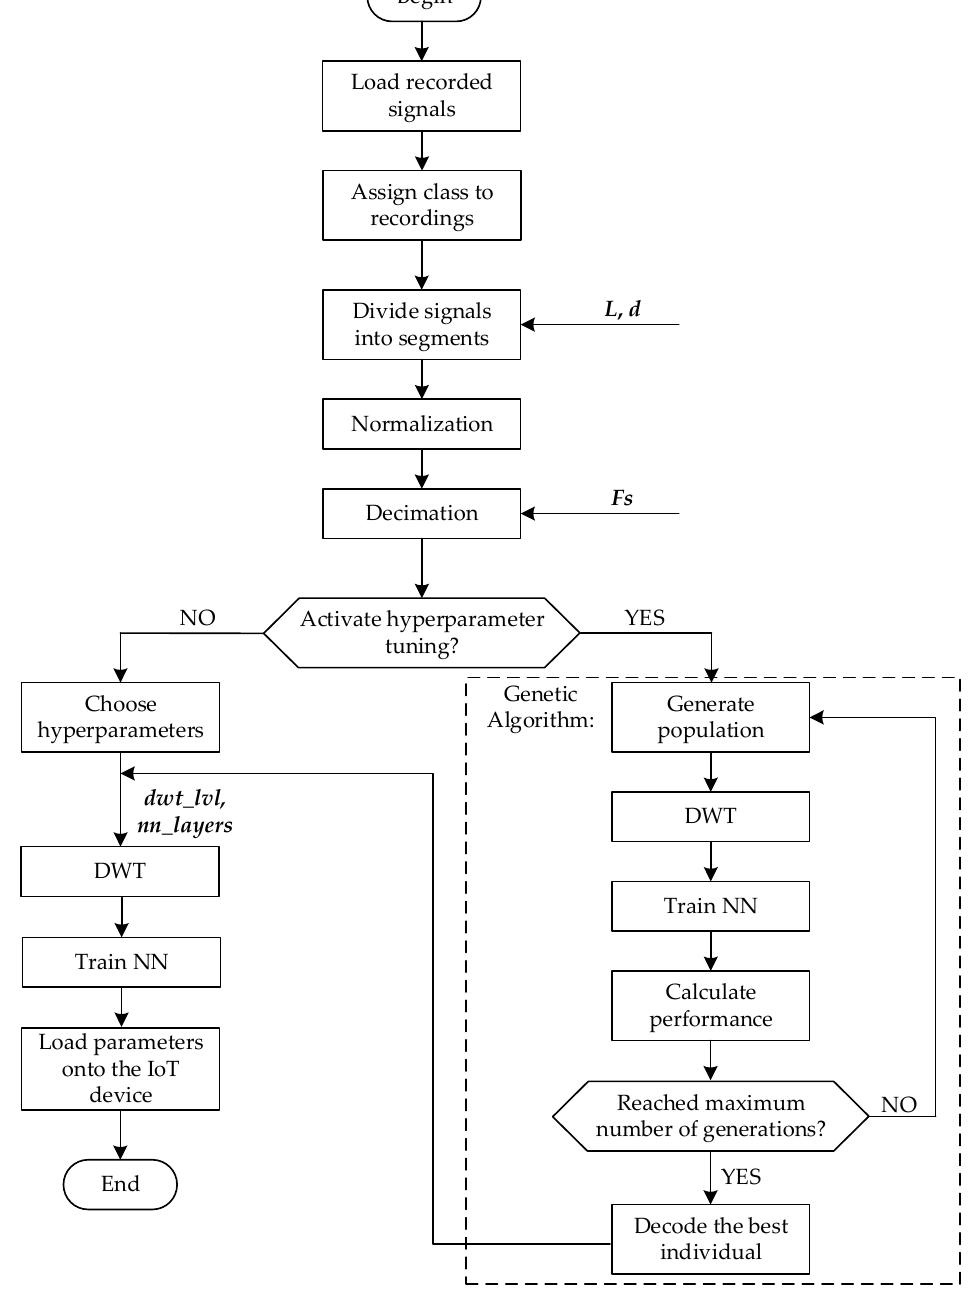
Figure 4. NN training and GA hyperparameter tuning.